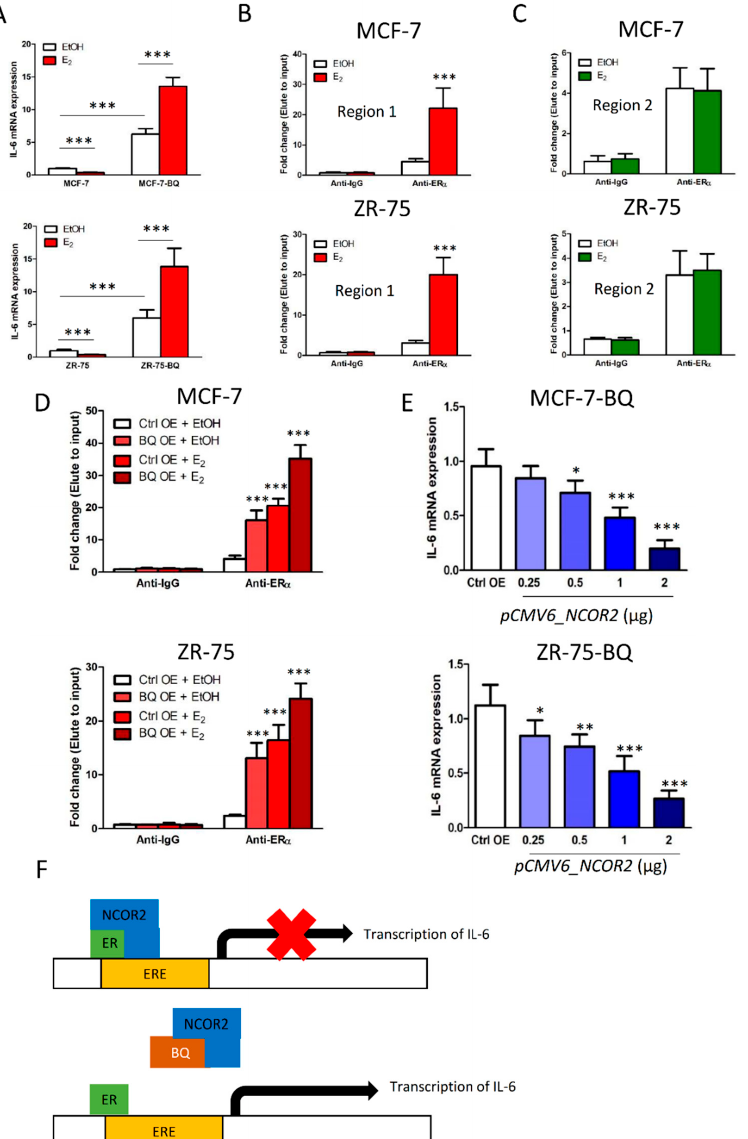
Figure 3. Overexpression of BQ could enhance IL-6 transcription through an Er α -dependent mechanism. ( A ) Overexpression of BQ could alter the effect of estrogen (E 2 ) on IL-6 expression. One nanomolar of E 2 was used. qPCR was performed after 48 h of the treatment. Actin was used as the internal control. Untreated cells were used as the reference. ( B ) E 2 could enhance ER binding to region 1 of IL-6 promoter. Chromatin immunoprecipitation (ChIP) was performed to determine protein–DNA interaction. ER α was immunoprecipitated. qPCR was used to determine the presence of the target DNA sequence. ( C ) E 2 could not enhance ER α binding to region 2 of IL-6 promoter. ( D ) Overexpression of BQ could enhance ER α binding to region 1 of IL-6 and the effect was further enhanced in the presence of E 2 . One nanomolar of E 2 was used. Stably transfected cell lines were used. ChIP assay was performed after 48 h of E 2 treatment. ER α was immunoprecipitated. qPCR was employed to determine the relative amount of DNA containing region 1 of IL-6 in the immunoprecipitant. ( E ) Overexpression of NCOR2 could compromise the effect of BQ on IL-6 expression in a dose-dependent manner. MCF-7-BQ and ZR-75-BQ cells were transfected with different amounts of pCMV-NCOR2 . pCMV6 was used as the control overexpression (ctrl OE). qPCR was performed 72 h post transfection to determine the mRNA expression of IL-6. Untransfected MCF-7-BQ or ZR-75-BQ was used as reference. Actin was used as internal control. ( F ) Schematic diagram showing the effect of BQ overexpression on the modulation of IL-6 expression through the ER-dependent pathway. In the presence of BQ overexpression, BQ binds with NCOR2. This interaction compromises the ability of NCOR2 to bind to ER α to repress transcription mediated by ER α . Results were shown as mean ± SD from at least three independent experiments. Students’ t test was used to determine the statistical significance between two groups. *, **, and *** represent p < 0.05, p < 0.01 and p < 0.001